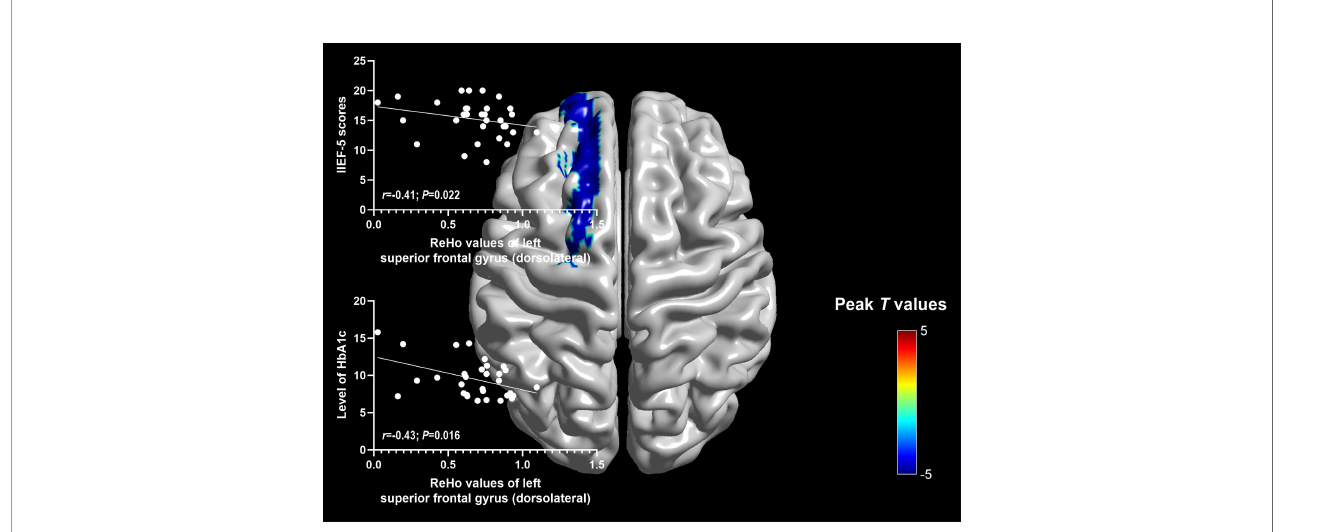
FIGURE 2 | Relationships between altered ReHo values and clinical characteristics in DM-ED